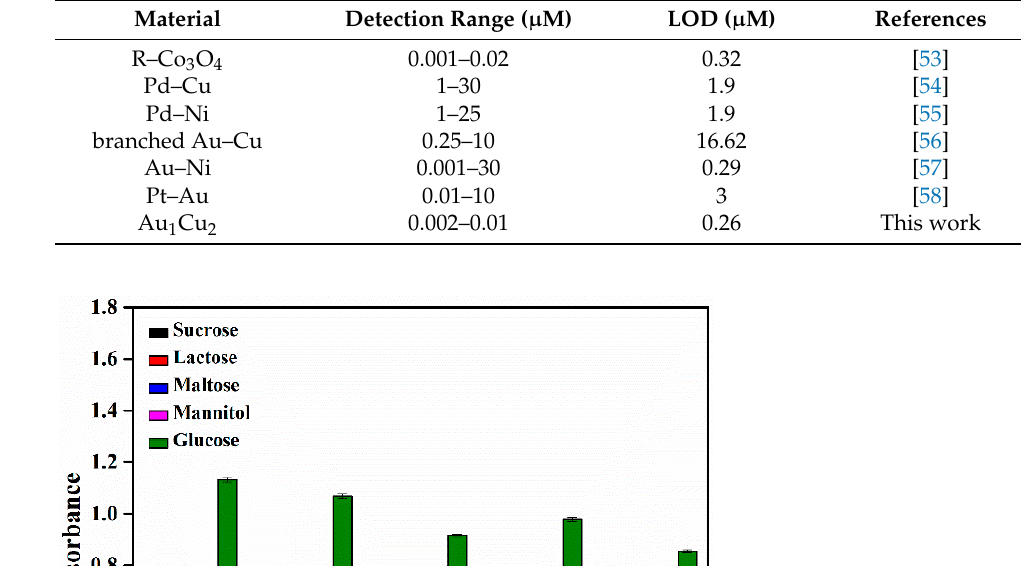
Figure 8. ( a – e ) Dose-response curves for glucose detection using ( a ) Au 1 Cu 0.1 , ( b ) Au 1 Cu 0.2 , ( c ) Au 1 Cu 0.5 , ( d ) Au 1 Cu 1 , and ( e ) Au 1 Cu 2 as peroxidase mimetics. Inset of a – e : Linear range of absorb- ance intensity versus H 2 O 2 concentration. ( f ) Limit of detection (LOD) for glucose of Au 1 Cu 0.1 , Au 1 Cu 0.2 , Au 1 Cu 0.5 , Au 1 Cu 1 , and Au 1 Cu 2 nanoparticles. Table 2. Analytical parameters of glucose detection in recent papers. Table 2. Analytical parameters of glucose detection in recent papers.